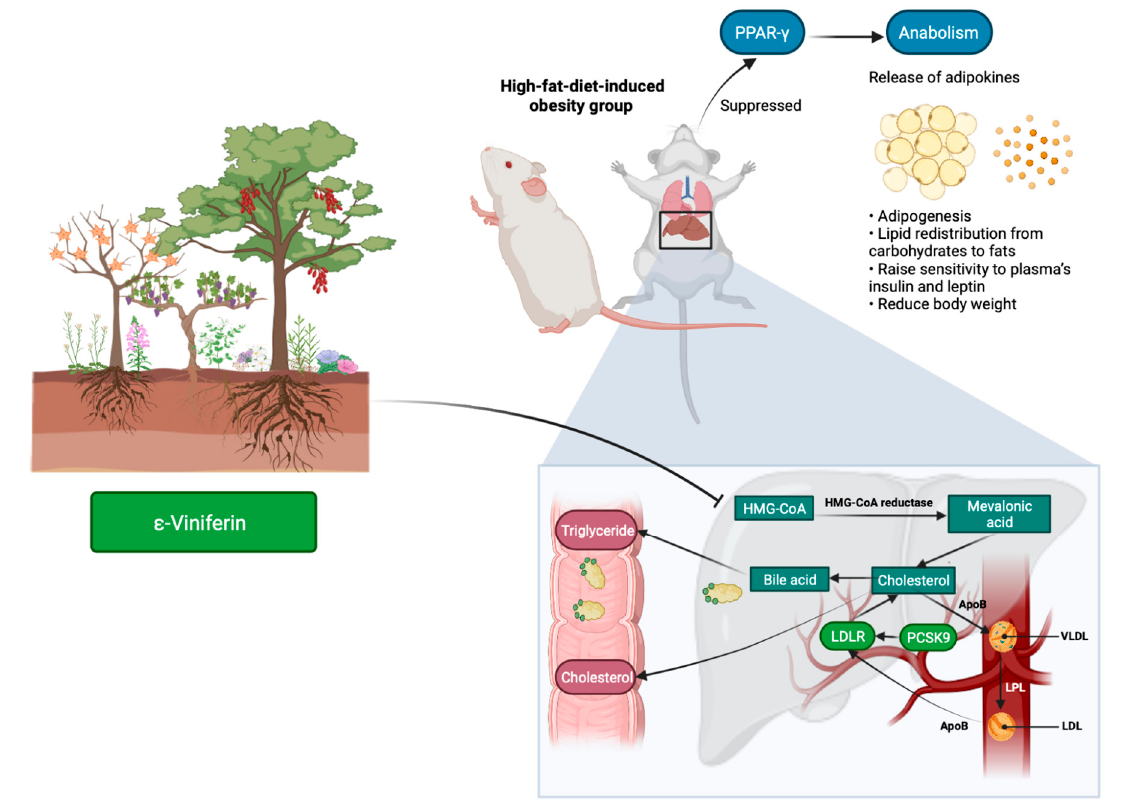
Figure 5. Anti-adipogenesis activity of ε -viniferin. The ε -viniferin suppressed PPAR- γ and HMG- CoA, which resulted in an anabolic process that stimulated adipogenesis and reduced body weight, liver triglycerides, total cholesterol and blood glucose. Abbreviations: HMG-CoA, β -Hydroxy β - methylglutaryl-CoA; PCSK9, Proprotein convertase subtilisin/kexin type 9; LDLR, Low-density lipoprotein receptor; LPL, Lipoprotein lipase; VLDL, Very Low Density Lipoprotein Receptor; LDL, Low-density lipoprotein; ApoB, Apolipoprotein B.